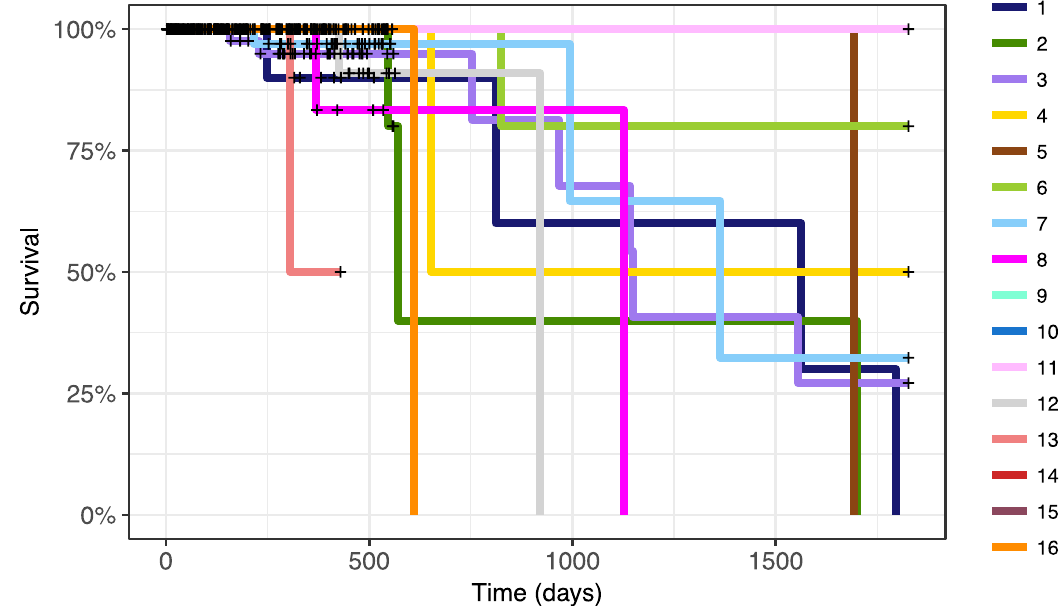
Fig 6. Survival curves for global clusters in the breast cancer dataset from TCGA, using the model with 3 context- specific clusters and up to 18 global clusters. The differencesbetween the survival curves are significantwith p = 0.0382using the